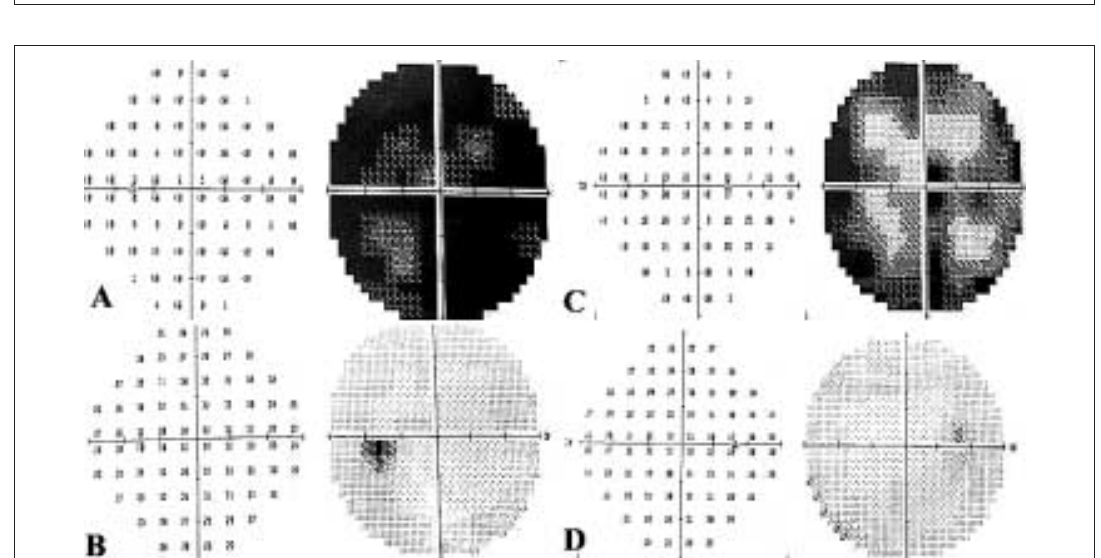
Visual field examina- tion of Case 1 after HBO treatment (L: left eye, R: right eye). Note: No visual field examination could be carried out due to low visual acuity before HBO therapy.